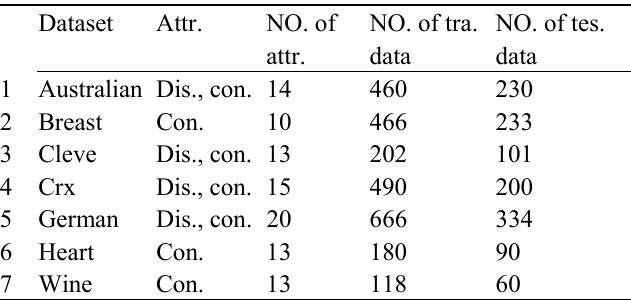
Table 10: Basic information of the datasets.